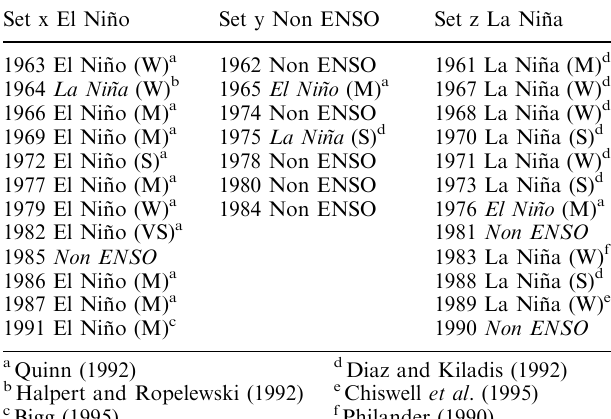
Table 1. Compositions of the three groups of years (x, y and z) in Fig. 1, together with ENSO classifications for each year (W weak, M moderate, S strong, and VS very